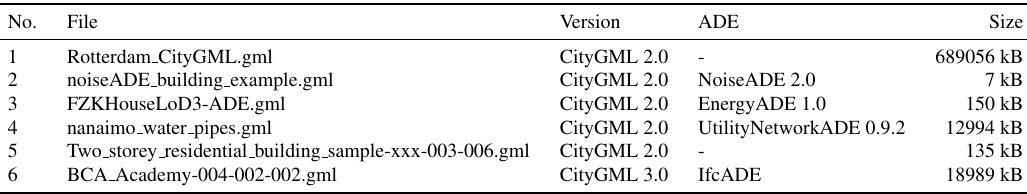
Table 1. List of datasets used in our